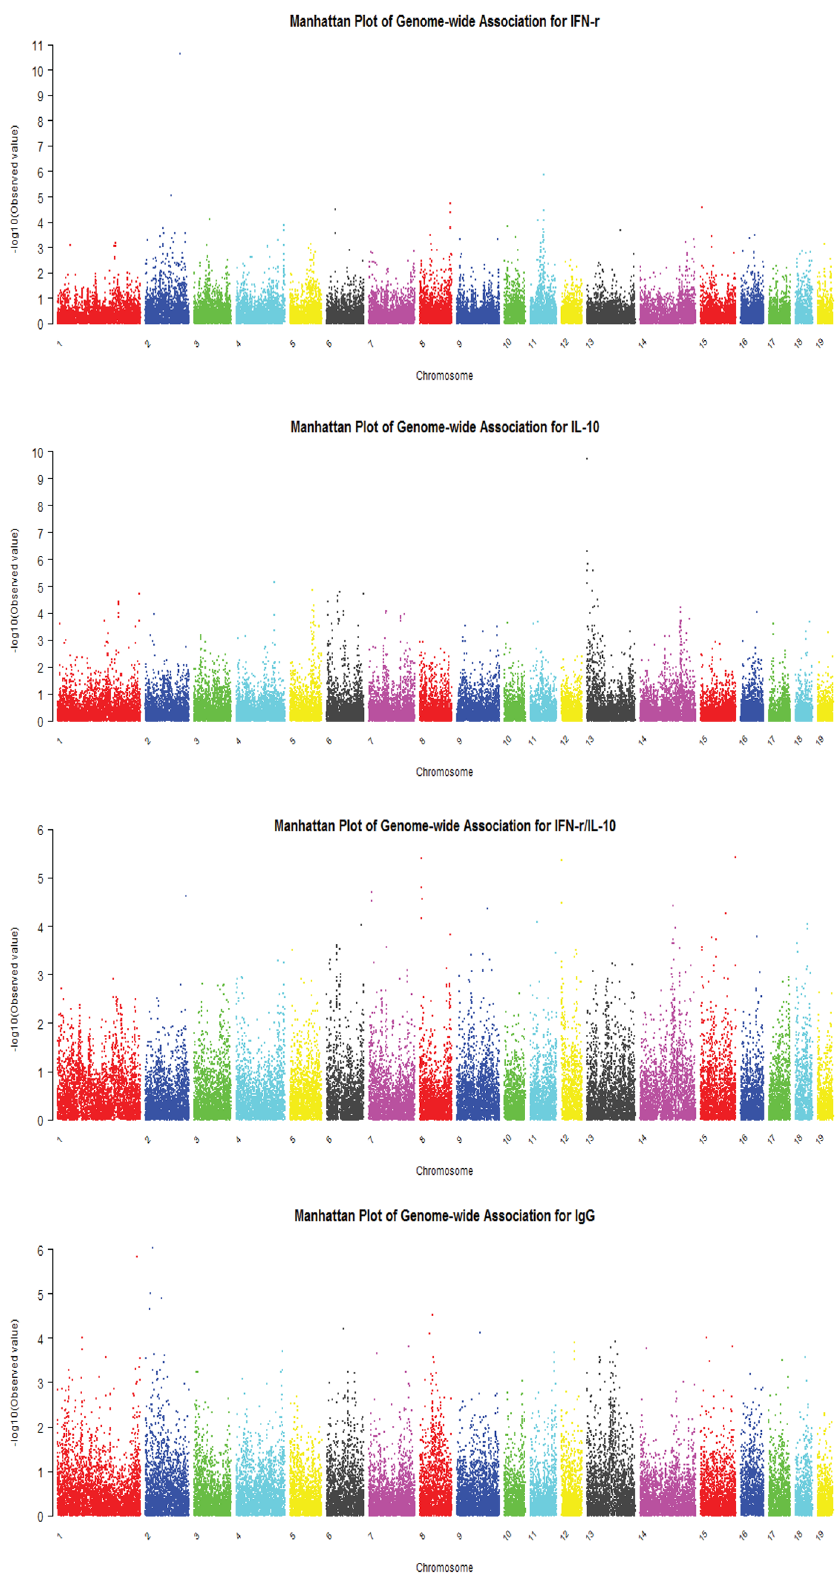
Figure 1. Manhattan plots of the P values of all tested SNPs (in terms of –log 10 P) for the four traits studied. Different chromosomes are represented by different colors. Chromosome 19 stands for the X chromosome of swine.